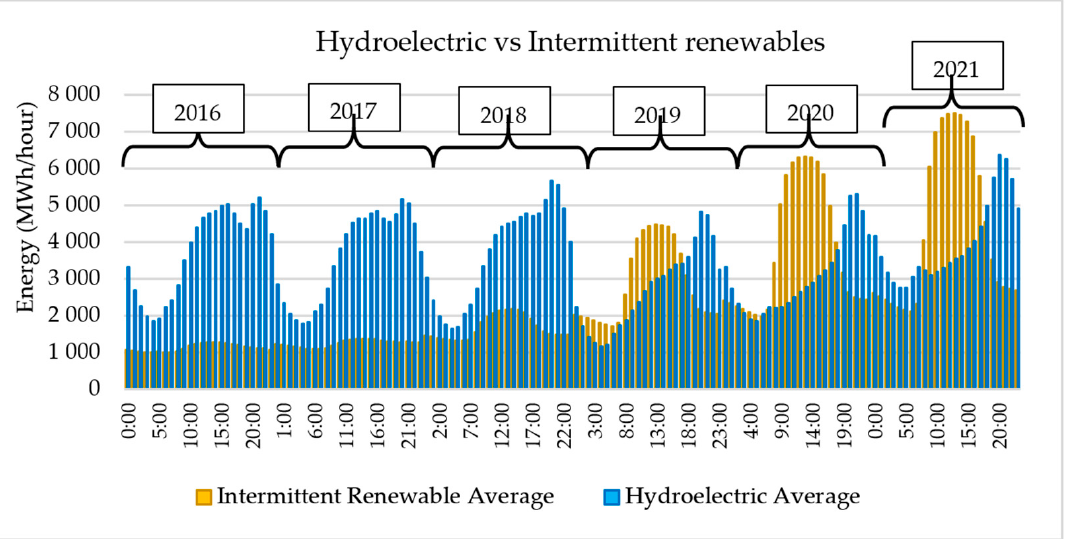
Figure 1. Historical participation of hydroelectric plants with variable renewables. Own source with CENACE data, 2021.